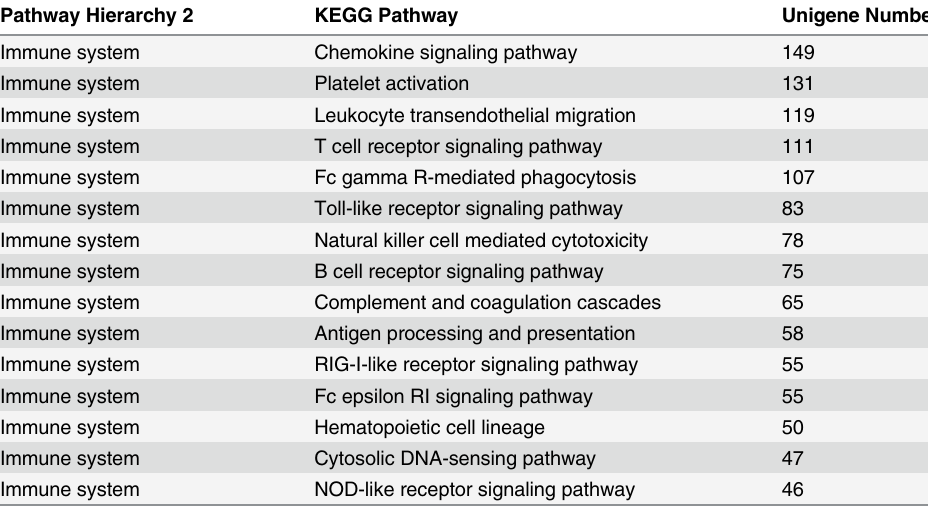
Table 4. Top 15 list of pathways related to immune